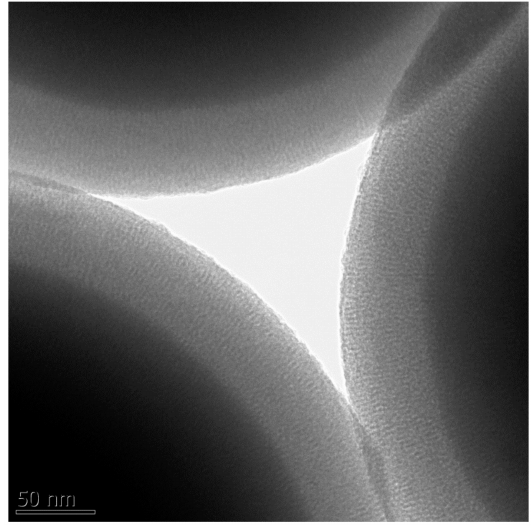
Figure 3. TEM image of 22 ◦ C-SCMS